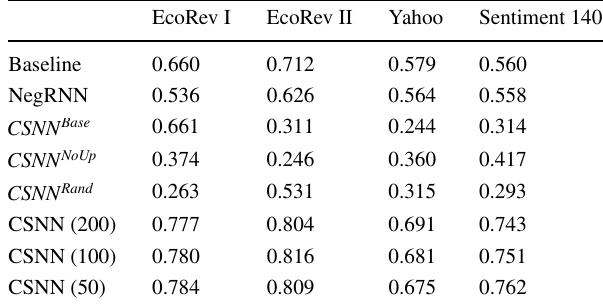
Table 4 Evaluation for explanation ability in SSL (Macro F 1 score)